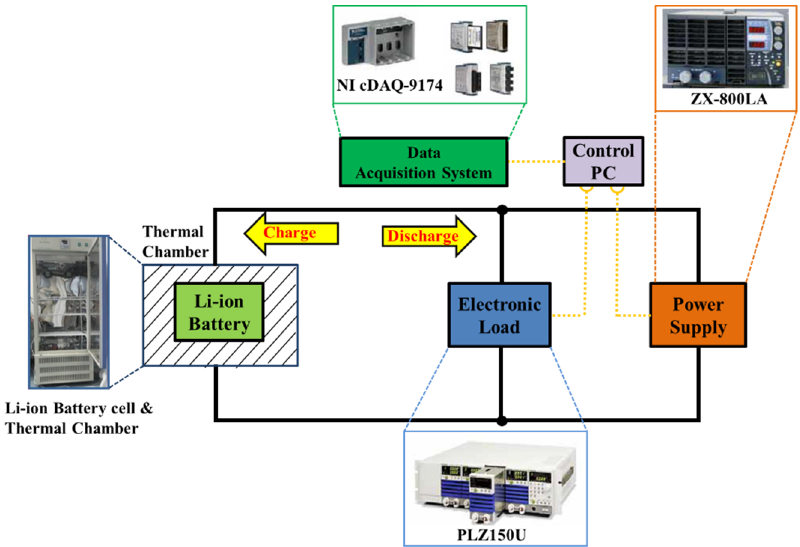
Figure 2. Schematic of battery test